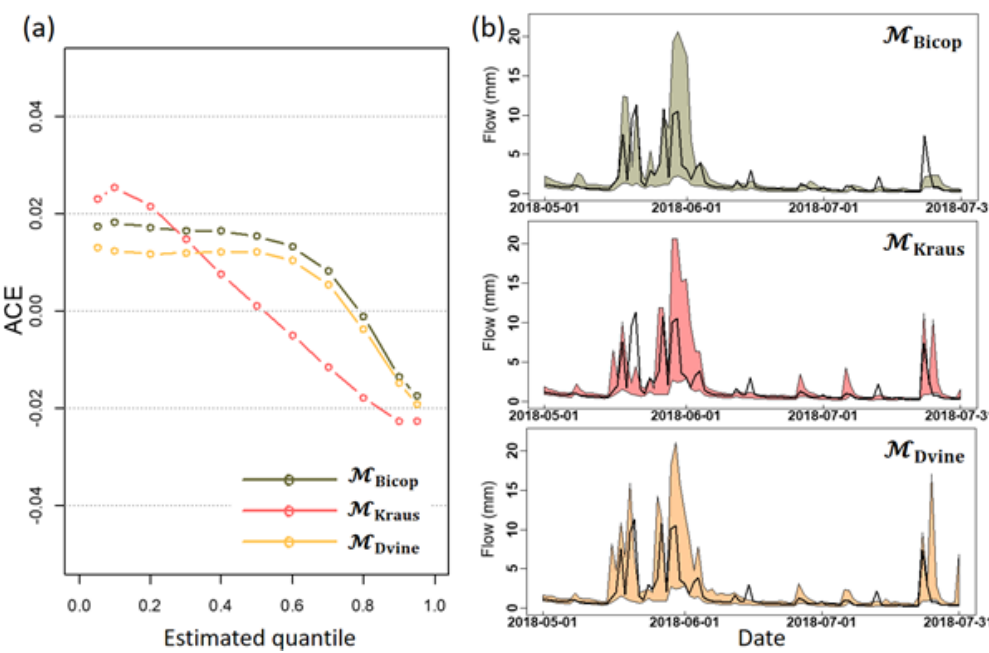
Figure 6. (a) Average coverage error from three copula-based models for the Yadkin–Pee Dee River basin across exemplary quantiles and (b) 95% PIs for three models for an example period (1 May to 31 July 2018) for a specific target gage (USGS site ID 02143500). Observed streamflow (black solid line) is also presented in each figure.